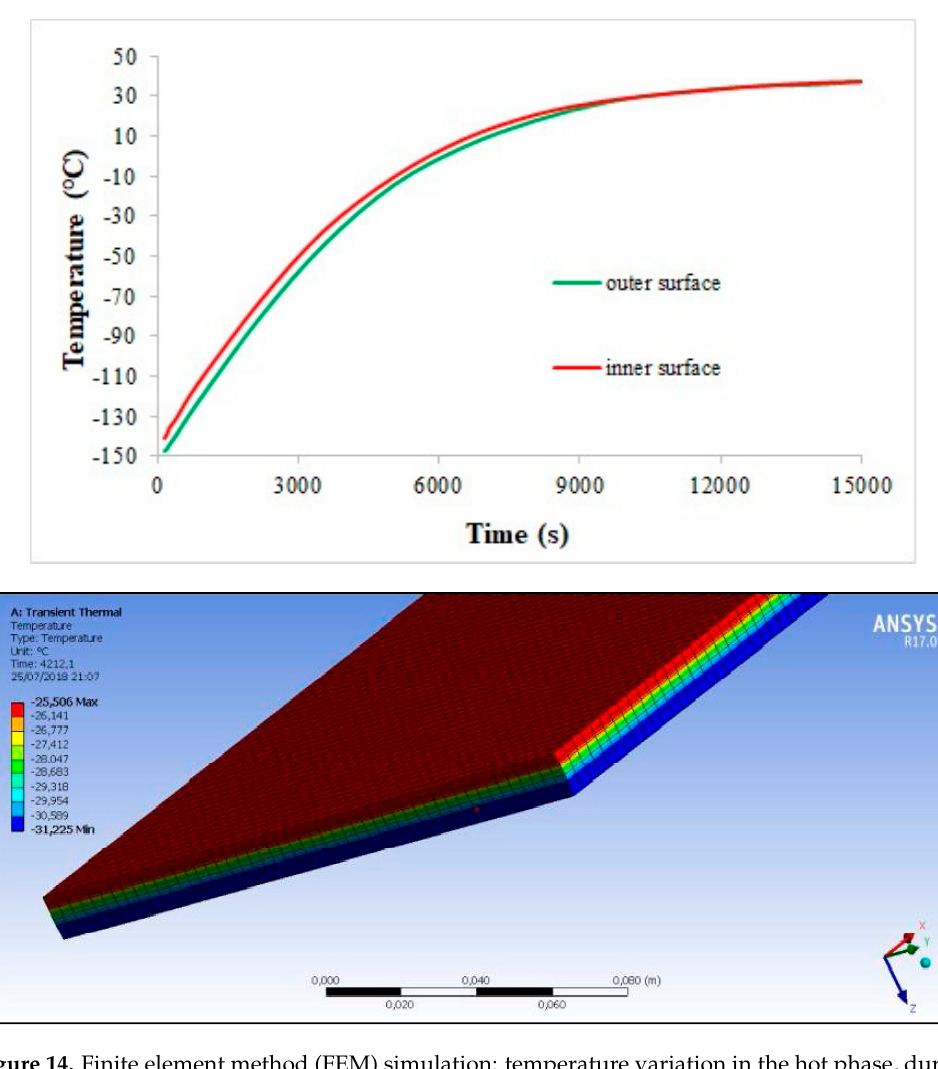
Figure 14. Finite element method (FEM) simulation: temperature variation in the hot phase, during the thermal cycle ( up ) and along the structure thickness at fixed time ( down ).